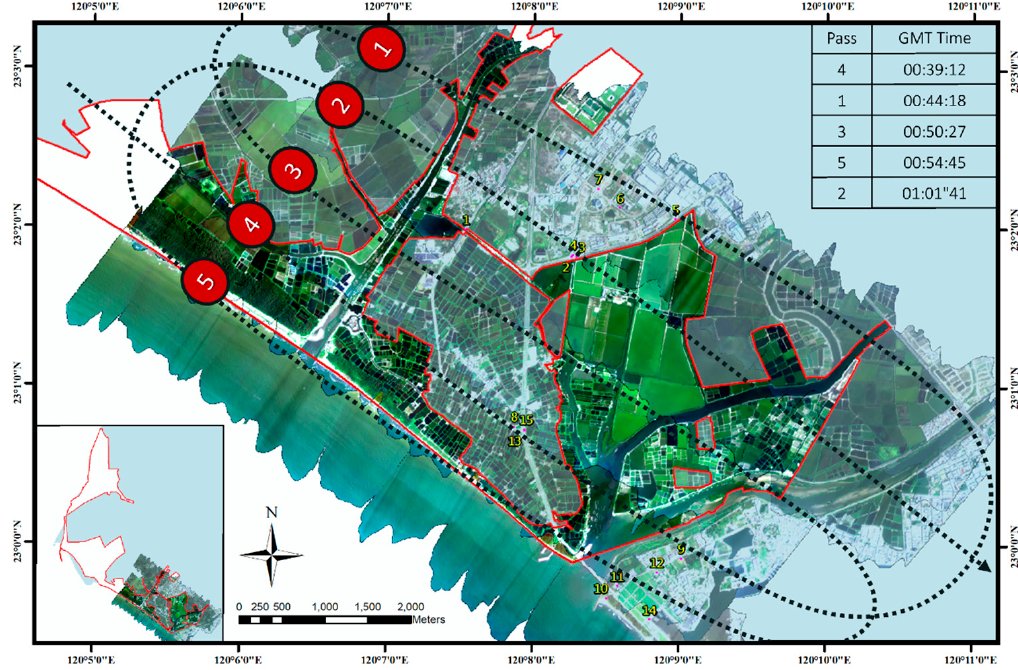
Figure 2. The color composite of five strips of hyperspectral images with a spatial resolution of 1 m that covered 25 km 2 , taken with the ITRES CASI 1500 at an altitude of 1000 m on 9 September 2013. The CASI scanner flight route is denoted as the dotted line. The Greenwich Mean Time (GMT) time of each pass is listed. The locations of 15 sites of ground measurements are labeled as fuchsia dots and yellow numbers.